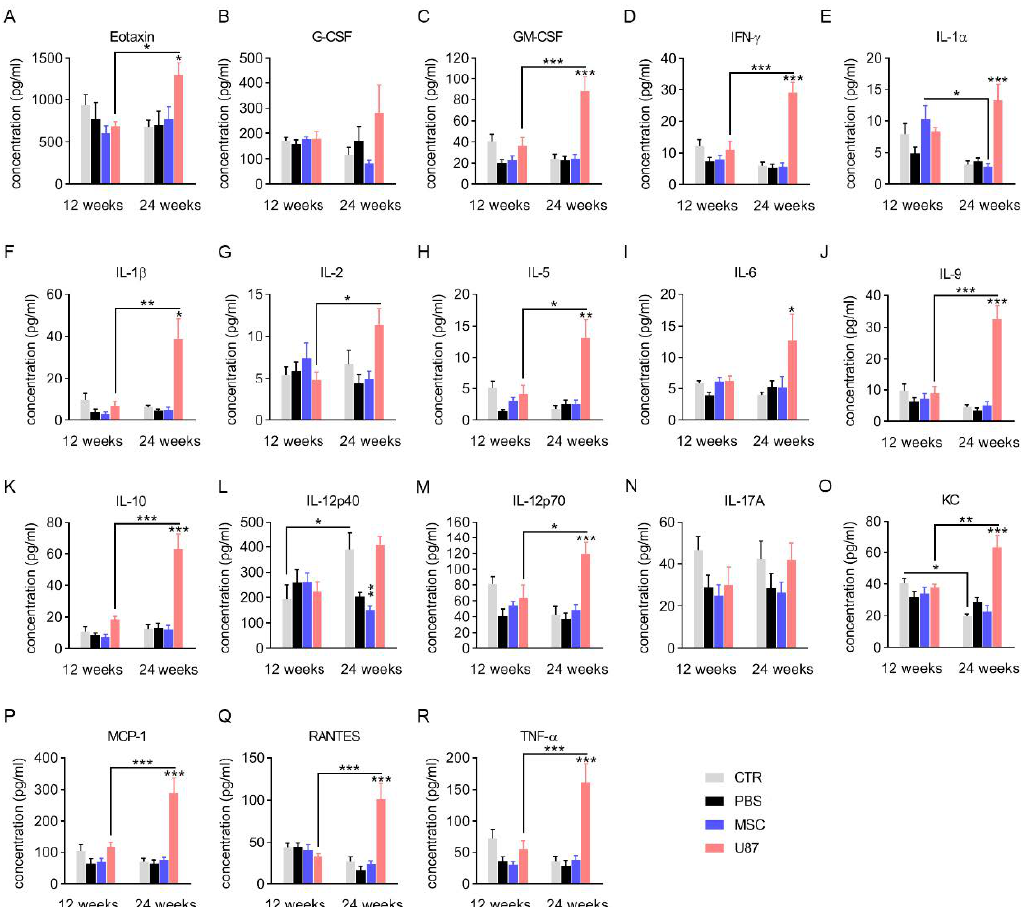
Figure 3. Analysis of inflammatory cytokine in blood plasma. Cytokine profile in the plasma of overnight fasted mice, 12 and 24 weeks-post cell treatment. ( A – R ) Bar graphs show the concentration levels of the cytokines. G-CSF, Granulocyte colony-stimulating factor; GM-CSF, Granulocyte Macrophage Colony-Stimulating Factor; IFN- γ , Interferon gamma; IL-1 α , Interleukin 1 alpha; IL-1 β , Interleukin 1 beta; IL-2, Interleukin 2; IL-5, Interleukin 5; IL-6, Interleukin 6; IL-9, Interleukin 9; IL-10, Interleukin 10; IL-12 (p40), Interleukin 12 subunit p40; IL-12 (p70), Interleukin 12 subunit p70; IL-17A, Interleukin 17A; KC, Keratinocytes-derived chemokine; MCP-1, Monocyte chemoattractant protein-1; TNF- α , Tumor necrosis factor α . Data are represented as mean ± SEM. n = 4–10 per group. * p < 0.05, ** p < 0.01, *** p < 0.001 compared to CTR group, unless otherwise indicated; One-way ANOVA.